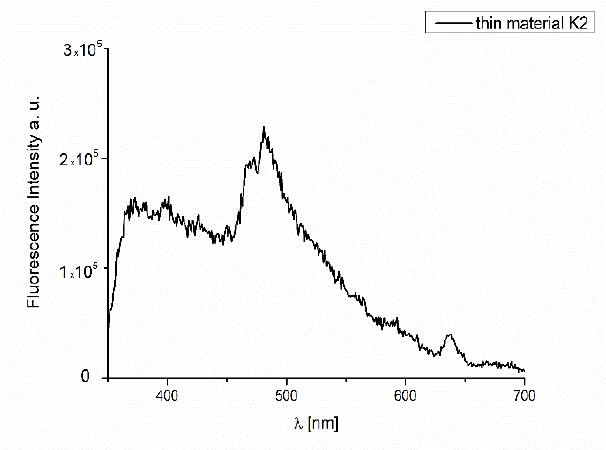
Figure 18. Emission spectra of the K2 material, λ ex =320 nm, spin coating.